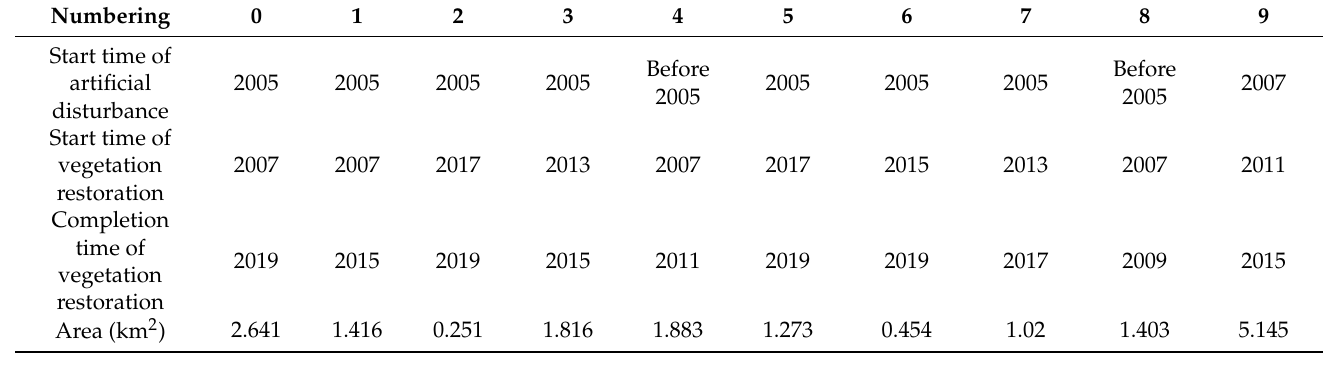
Table 5. The area of vegetation restoration area and the start year of damage and restoration.